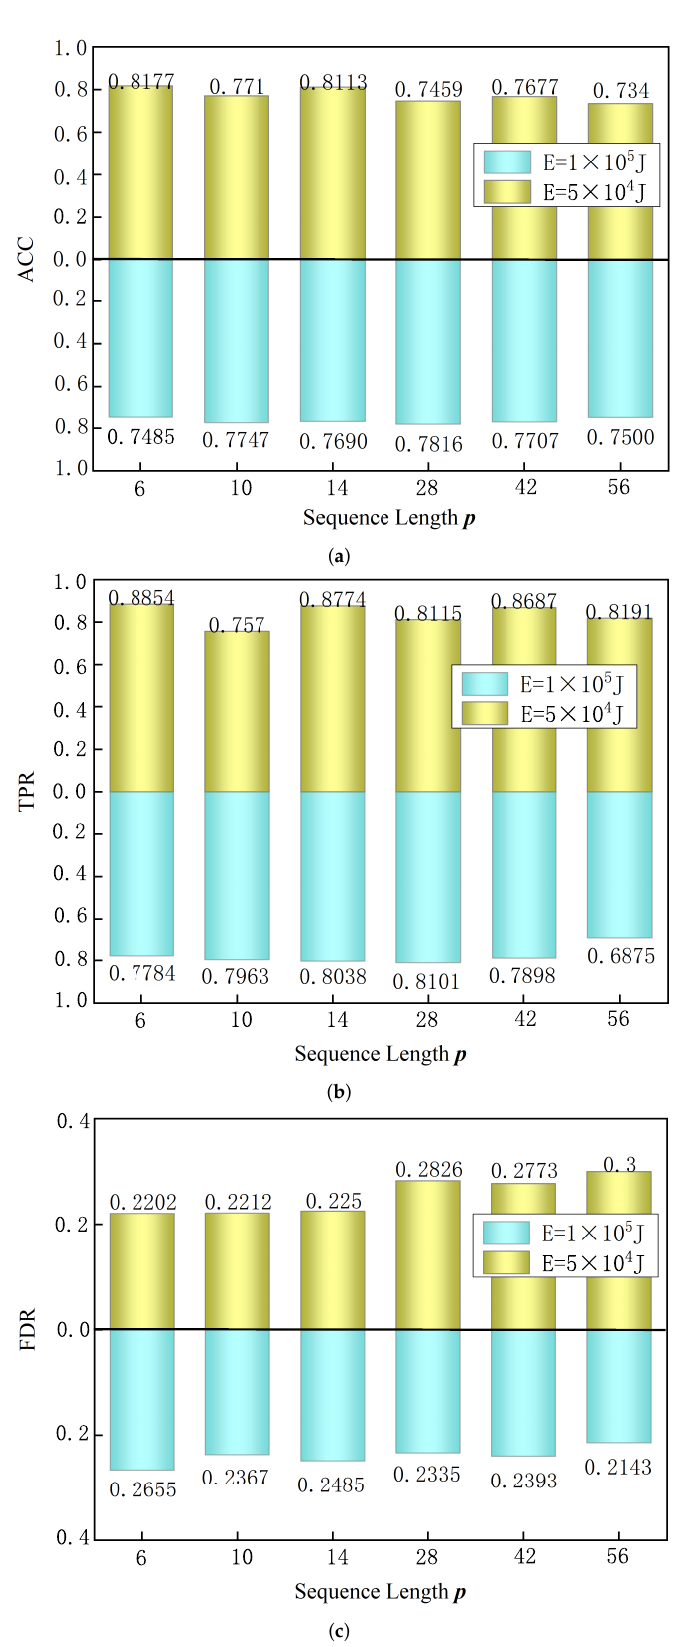
Figure 6. Test results of different sequence lengths including ( a ) ACC, ( b ) TPR, ( c )